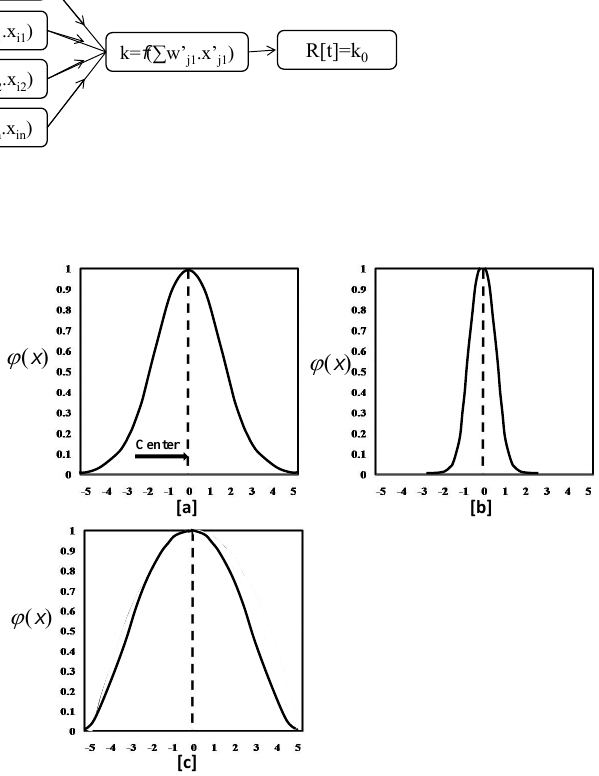
Figure 3: Radial Basis function with different levels of spread [a] Normal spread Fig. 3. Radial basis function with different levels of spread. (a) nor- mal spread, (b) small spread, (c) large